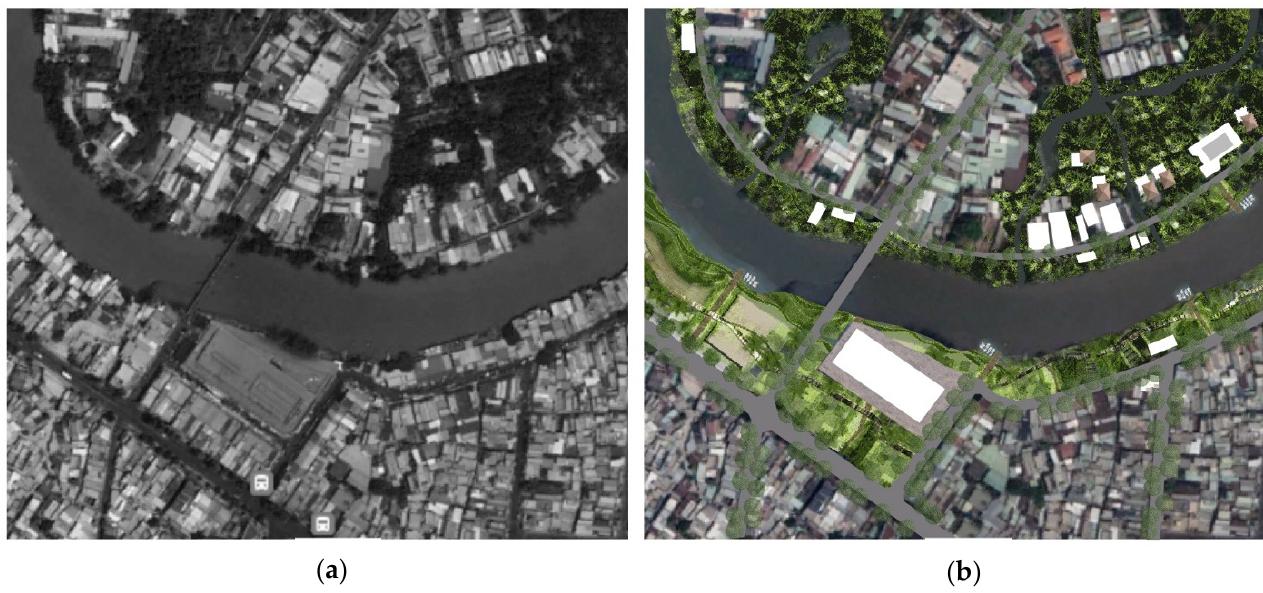
Figure 14. Restoring ecological services of the canals is the main goal of EI at the sub-area scale. The (partly) filled canals ( a ) will be returned to water space for the construction of riverine flooded parks, the riverine ecosystem will gradually be restored over time ( b ). Source: Drawn based on Google Maps images, location: My Tho City, Vietnam (https://www.google.com/maps, accessed on 22 March 2022)